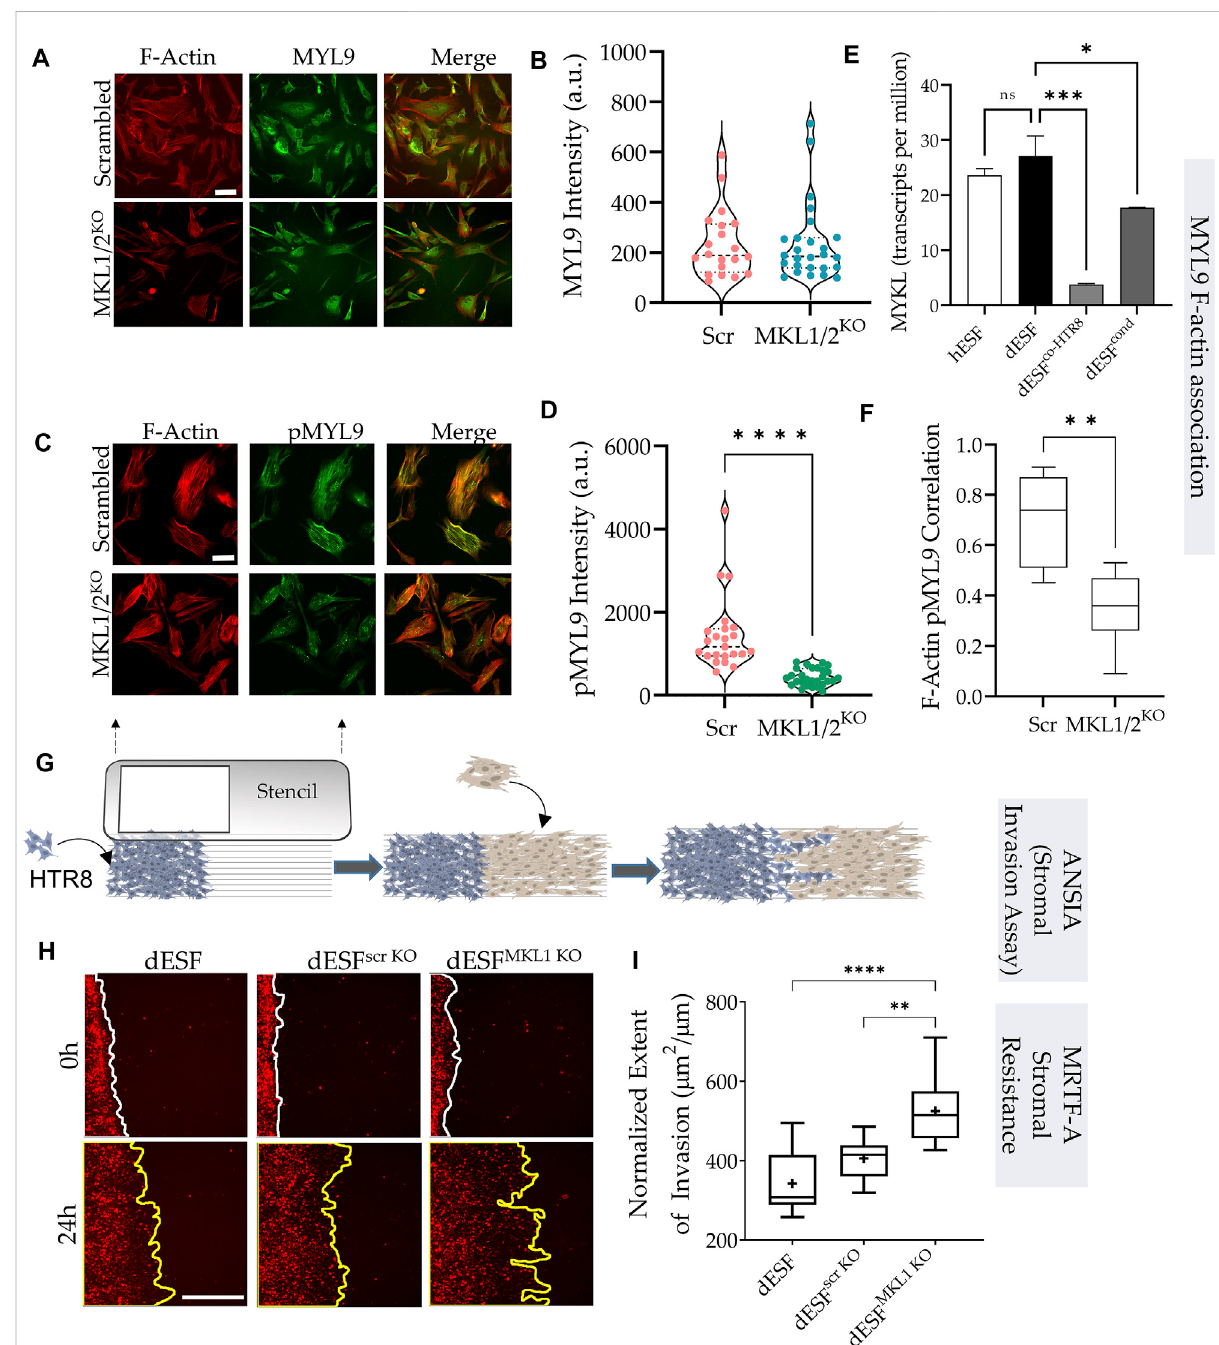
FIGURE 4 MRTF silencing in decidual fi broblasts reduces actomyosin contractility and resistance to trophoblast invasion. (A) Immuno fl uorescence of dESFswithCRISPR/Cas9basedgenesilencingforscrambledcontrol,andMKL1&MKL2(MKL1/2 KO )showingF-actinandmyosinlightchain-9(MYL9), quanti fi cationofintensity percell forMYL9shows nostatistical difference (B) ;scale bar=25 µm. (C) Immuno fl uorescenceimagesshowingreduced abundanceofphospho-MYL9 in MKL1/2 KO dESFs (D) ;scale bar =20 µm. (E) Relative expression of myosin lightchain kinase (MYLK) hESF, dESF, aswellasdESFsco-culturedorconditionedwithHTR8. (F) Pearson ’ scoef fi cientofphospho-MYL9(green)co-localizationwithF-actin fi bers(red)in Scrambled control, and MKL1/2 KO dESFs. (G) Schematic showing the setting of the ANSIA assay to measure stromal invasion of H2B-mCherry expressing HTR8s in the dESF monolayer on a nanopatterned substrate with the anisotropic nanoridges aligned orthogonal to the patterned HTR8- dESF interface. (H) Representative time-stamped images of HTR8 (red)-dESF (unlabeled) interface at 0 and 24 h, with dESFs either silenced with scrambled gRNA, or gRNA targeted towards MKL1. (I) Extent of stromal invasion by H2B-mCherry labeled HTR8 cells into the dESF monolayer for conditions in e, and signi fi cance is calculated using Anova followed by Tukey ’ s test; n > 10 per